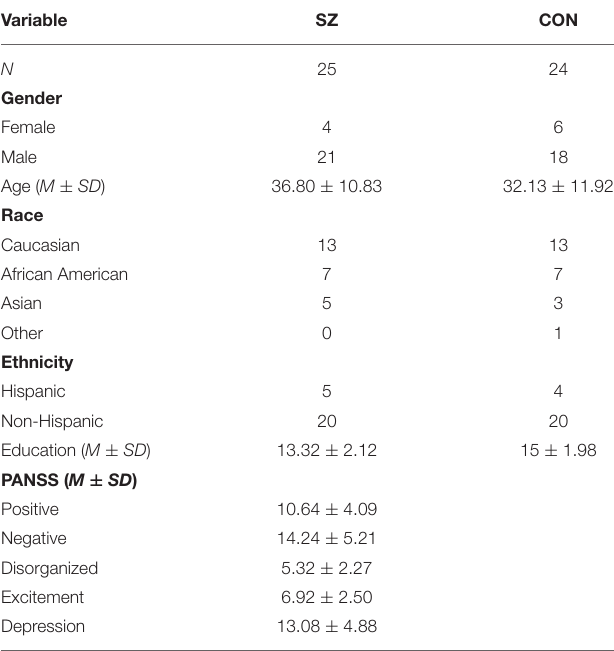
TABLE 1 | Individual demographic